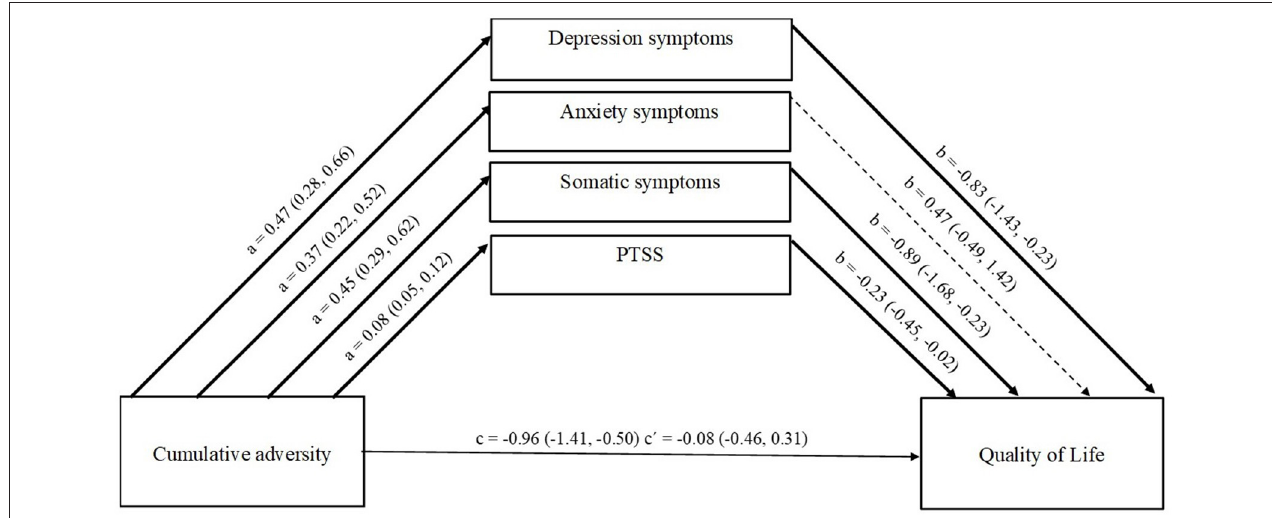
FIGURE 1 | Effect of multiple mediators on the relationship between Cumulative Adversity and Quality of Life. a, effect of TLEs on mediators; b, effect of mediators on Quality of Life; c, direct effect of TLEs on Quality of Life; c ′ , indirect effect of TLEs on Quality of Life through the four mediators. Values are unstandardized coefficients and Bootstrap Confidence Intervals.